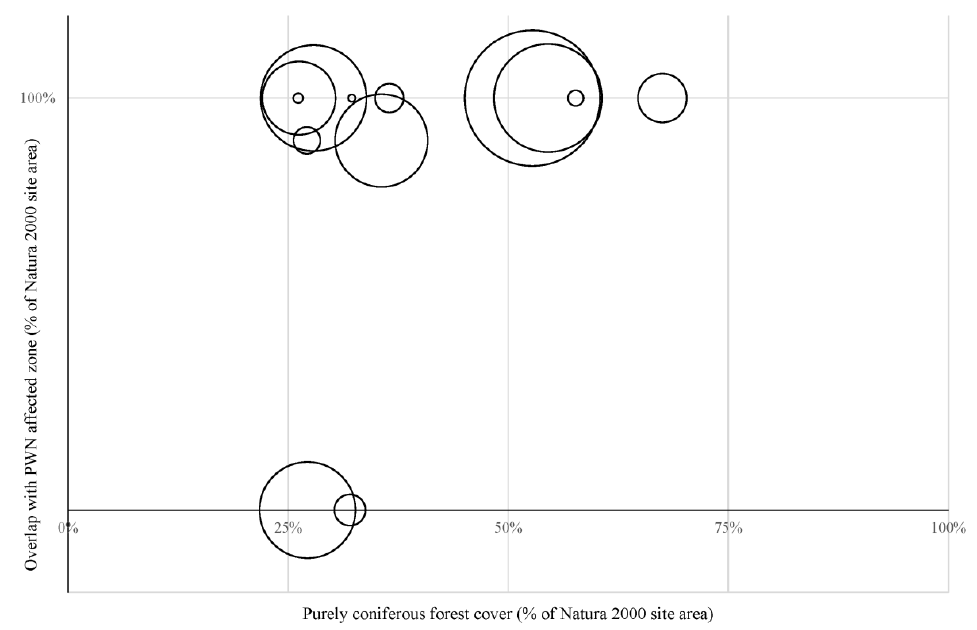
Figure 2. Areal overlap between Natura 2000 sites and the pine wood nematode affected zone (vertical axis) versus the purely coniferous forest cover in these sites (horizontal axis). Data are shown for the 13 Natura 2000 sites of mainland Portugal with at least 25% of their area covered by purely coniferous forests. The area of the circles is proportional to the total area of each Natura 2000 site (the maximum circle size corresponds to the 32,049 ha of the largest of these 13 Natura 2000 sites).